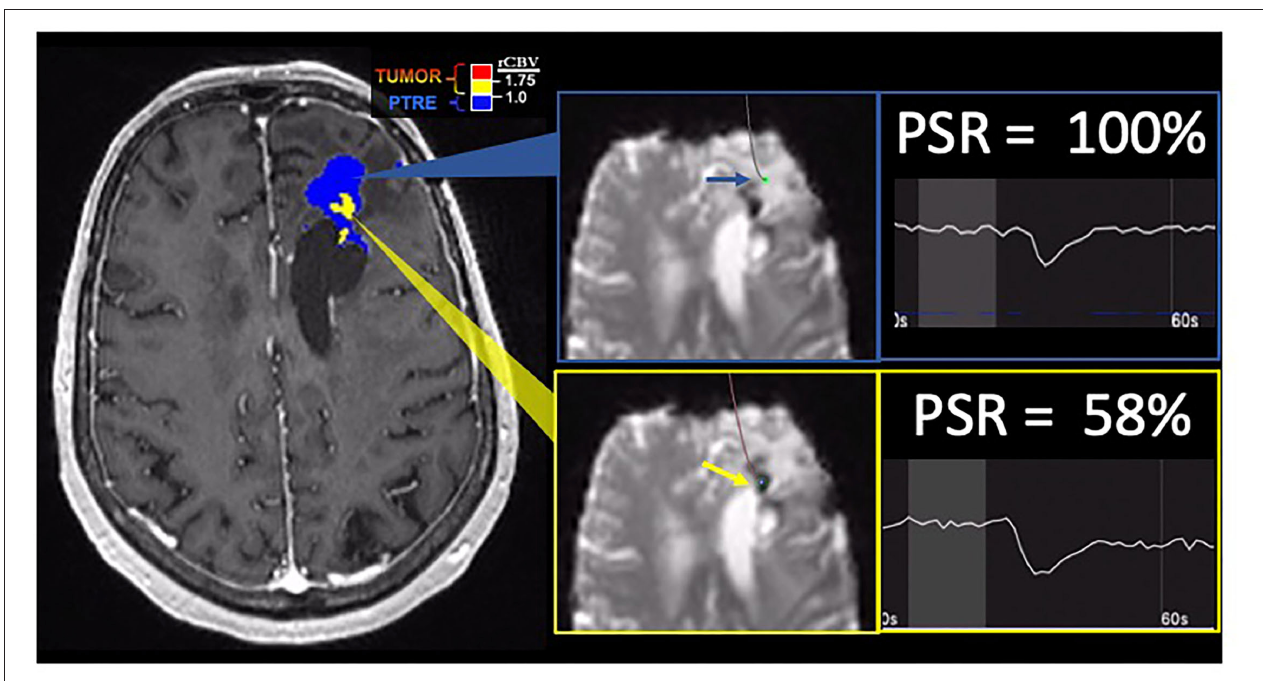
FIGURE 4 | Percentage signal recovery in PTRE and recurrent tumor: A 68-year-old woman with left frontal GBM with two prior surgical resections and adjuvant radiation, temozolomide, and lomustine therapy undergoing routine surveillance imaging. DSC was performed due to concern for tumor recurrence (refer to Figure 2 ). The FTB map shows peripheral low rCBV (blue) consistent with PTRE which was confirmed on stereotactic biopsy. The central component with higher rCBV (yellow) was presumed to have a recurrent tumor and resected, but not confirmed with stereotactic biopsy. Correlating PSR maps and signal intensity-time curves are provided to demonstrate a high PSR of essentially 100% for the peripheral region consistent with the PTRE and a lower PSR of 58% for the central region that was presumed to have a recurrent